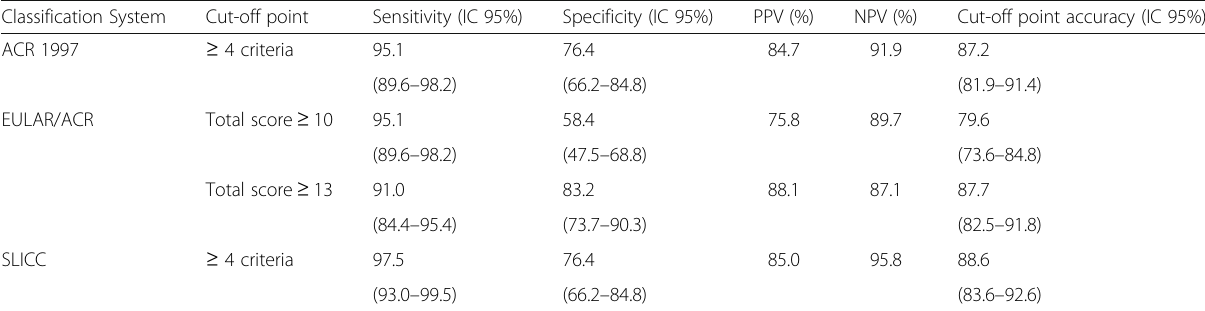
Table 5 Performance measures for ACR 1997, SLICC and new EULAR/ACR criteria, at 1-year-follow-up Classification